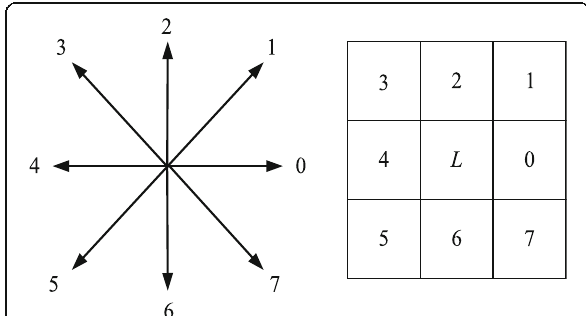
Fig. 8 The direction chain code of pixel L